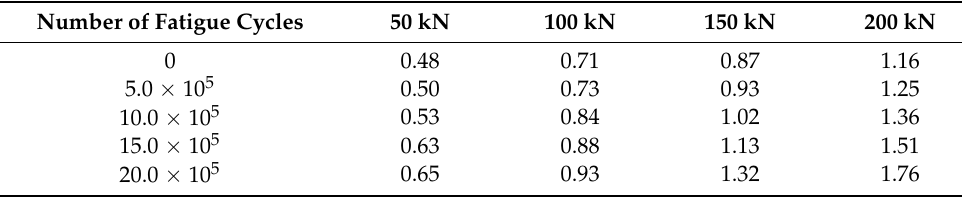
Table 9. Table for variation of the deflection of the bonded steel plate reinforced test plate in span, with number of fatigue damages after freeze–thaw damage